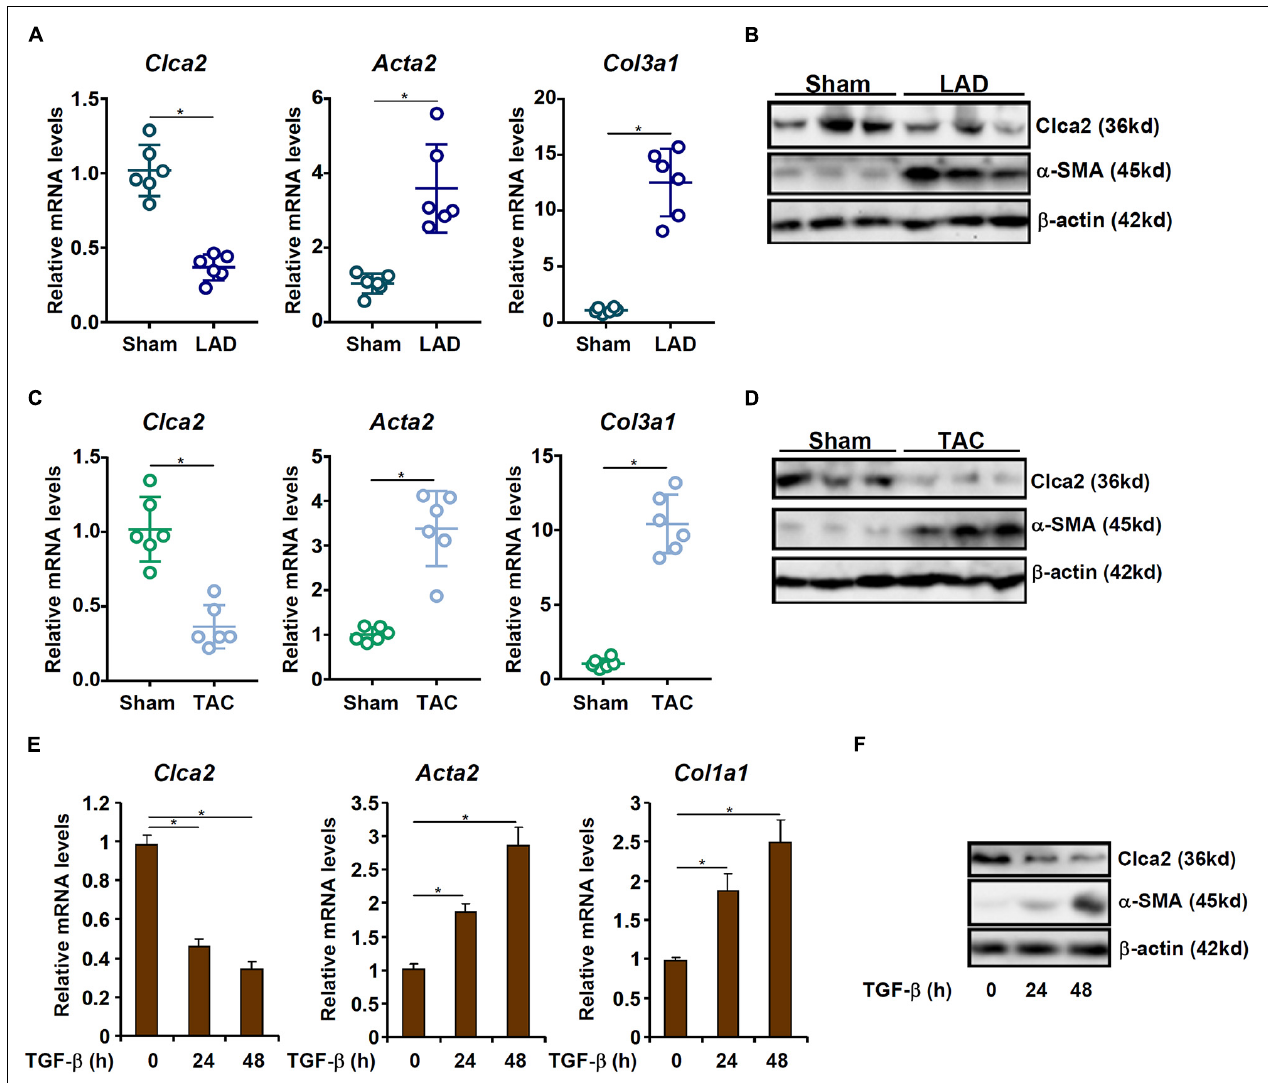
FIGURE 1 | Chloride channel accessory 2 (Clca2) expression is down-regulated in activated cardiac fibroblasts. (A,B) C57B/6 mice were subjected to the LAD procedure to induce myocardial infarction. The mice were sacrificed 7 day after the surgery and primary cardiac fibroblasts were isolated. Clca2 expression was examined by qPCR and Western. N = 6 mice for each group. (C,D) C57B/6 mice were subjected to the TAC procedure to induce myocardial hypertrophy. The mice were sacrificed 7 day after the surgery and primary cardiac fibroblasts were isolated. Clca2 expression was examined by qPCR and Western. N = 6 mice for each group. (E,F) Primary cardiac fibroblasts were isolated from C57B/6 mice and treated with TGF- β (2 ng/ml). Cells were harvested at indicated time points and Clca2 expression was examined by qPCR and Western. Error bars represent SD (* p < 0.05, two-way Student’s t -test). All experiments were repeated three times and one representative experiment is